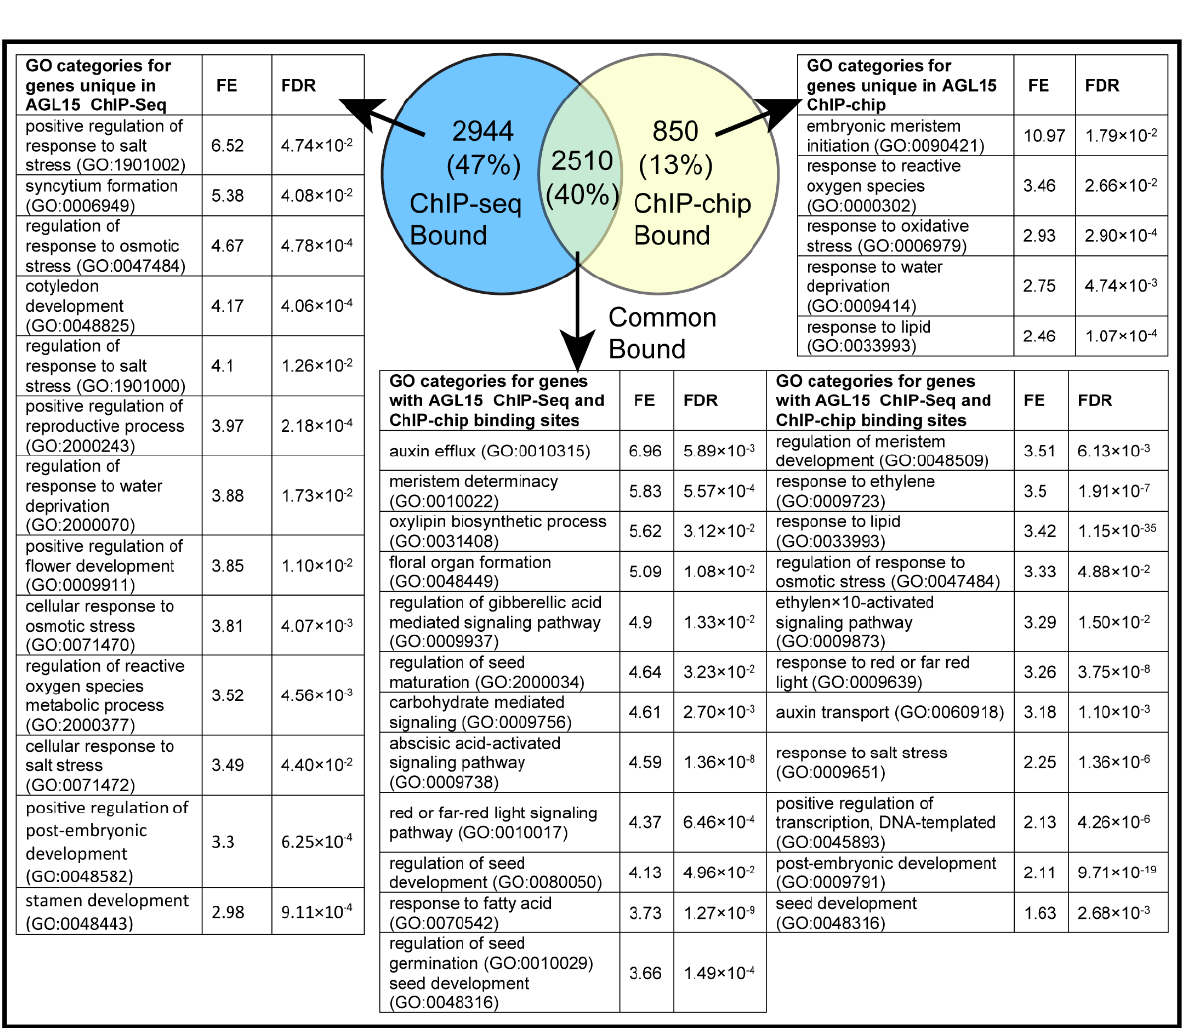
Figure 1. GO enrichment analysis for genes with regulatory regions associated with AGL15 ChIP- chip, ChIP-Seq, or both approaches. Panther classification system was used to find the significantly overrepresented categories. Fold enrichment compares the dataset to the whole Arabidopsis genome (release 16 November 2021). The number of genes identified as associated with AGL15 in each and common to both approaches is shown. Please note that the number of binding sites is larger for each approach than the number of genes associated because some genes have more than one AGL15 binding region identified. FE indicates fold enrichment (please see the text).